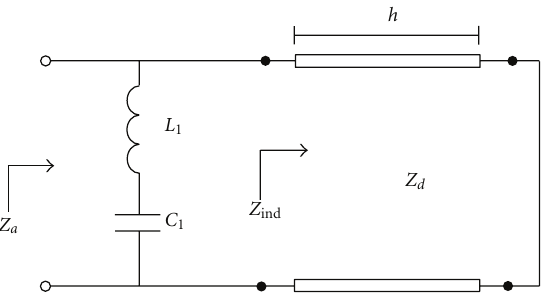
Figure 5: Equivalent circuit of grounded reflecting surface.